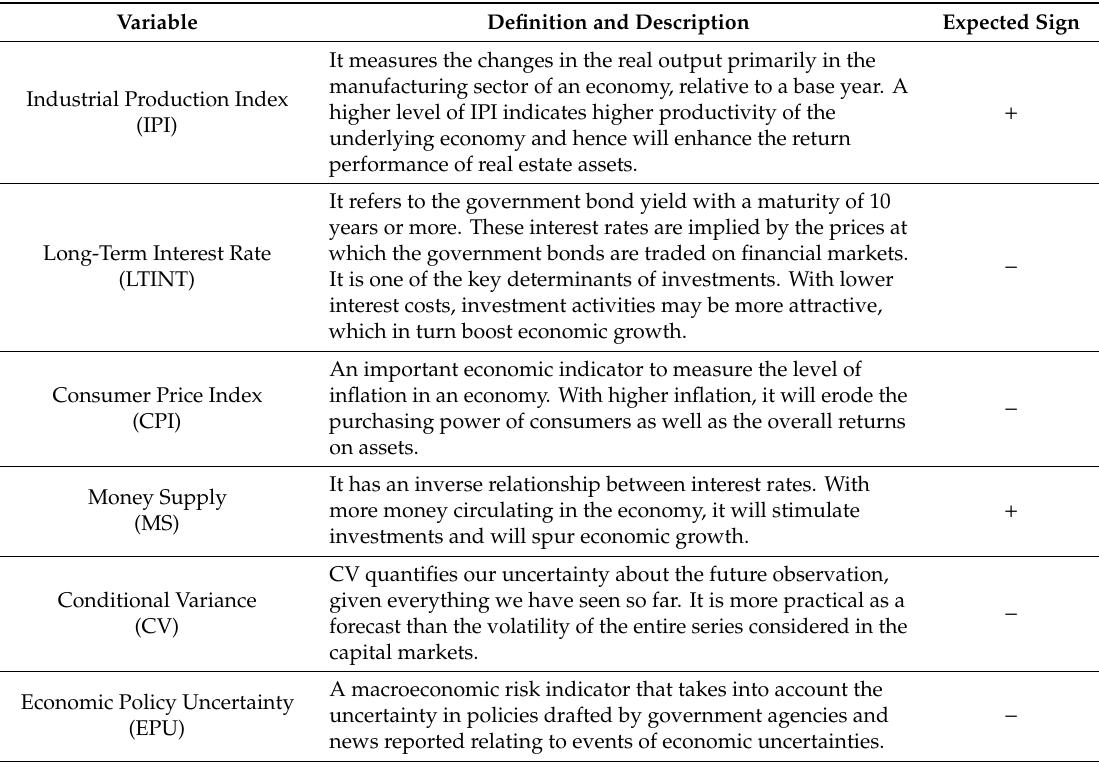
Table 2. Summary of the explanatory variables used in the